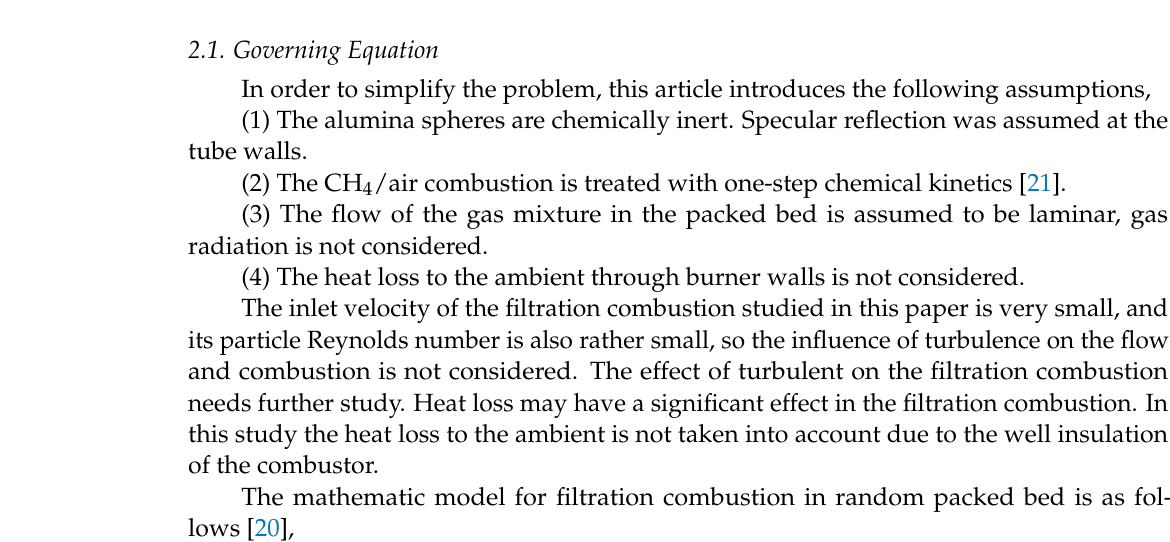
Figure 1. Three-dimensional random bed model.